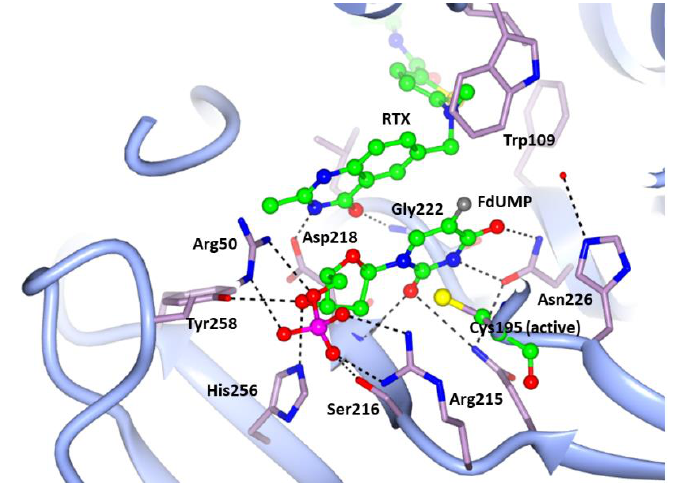
Figure 3. Interactions of FdUMP and RTX (balls and sticks, green carbons) within the active site cavity of hTS (light blue cartoon, residues in sticks, lilac carbons), as they occur in subunit C (Arg175′ and Arg176′ are omitted for clarity). Dashed lines represent H-bonds occurring between the inhibitors and the enzyme. Nitrogen, oxygen, and sulfur atoms are shown in the conventional blue, red, and yellow colors. Phosphorus and fluorine atoms are displayed as magenta and gray spheres, respectively.